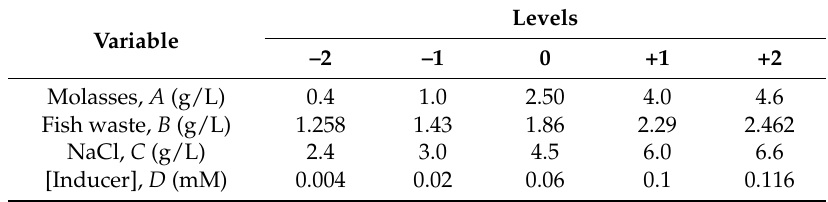
Table 7. Range of Variables and Their Levels for the Central Composite Rotatable Design